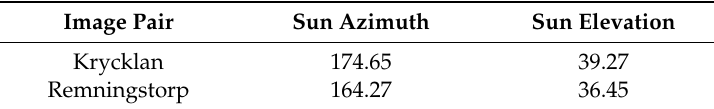
Table 4. Sun elevation angles (°).